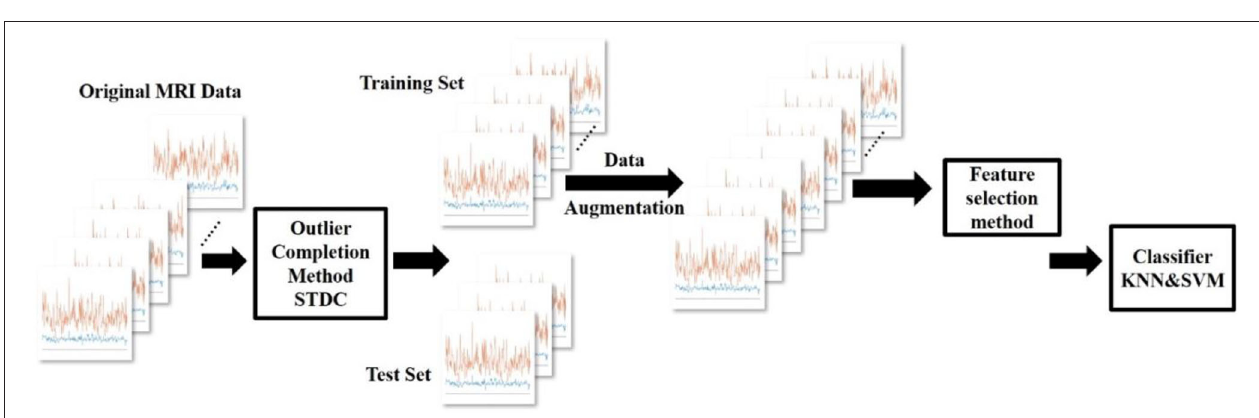
FIGURE 8 | The data augmentation process on the UVic-GC dataset with GEMD and feature selection experiment.